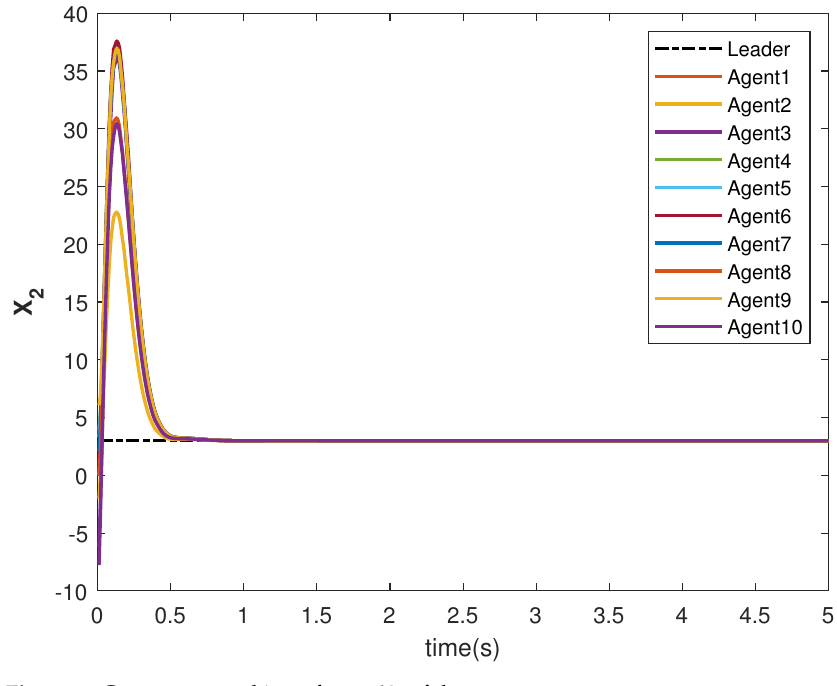
Figure 4. Consensus tracking of state X 2 of the agents.